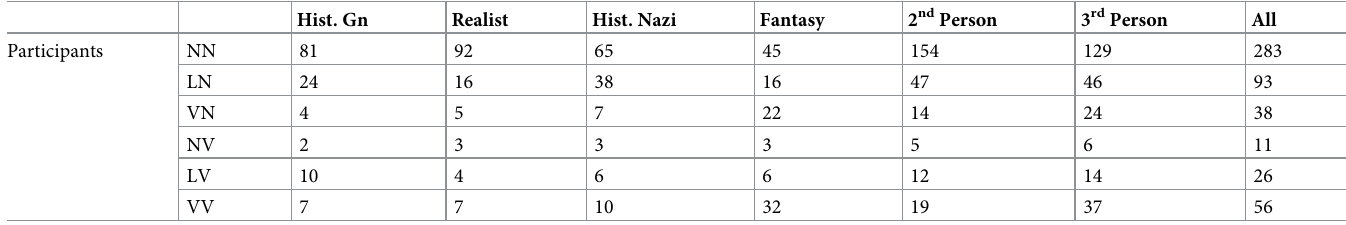
Table 2. Choice path distribution by genre and perspective (N = 507). Hist.